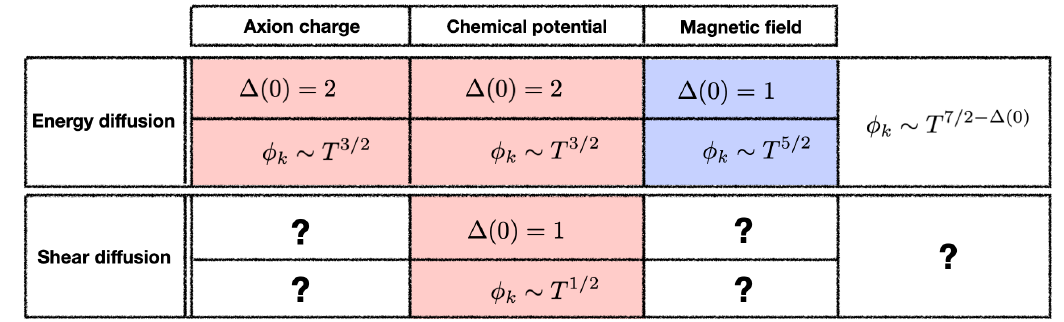
Table 1 . The summary for the study of the breakdown of hydrodynamics with ( ω eq , k eq ). Red region is investigated in [12] and the blue region is considered in this